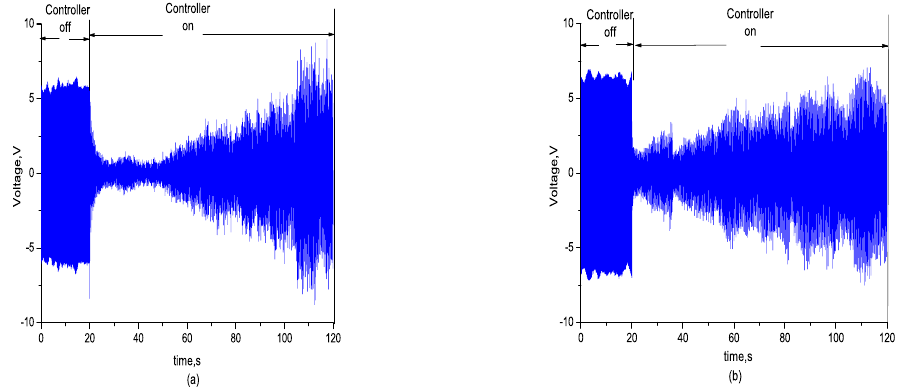
Figure 17. ( a ) Self-sensing signal vs. C (cid:48) p = 12 nF; ( b ) self-sensing signal with no local strain compensation.